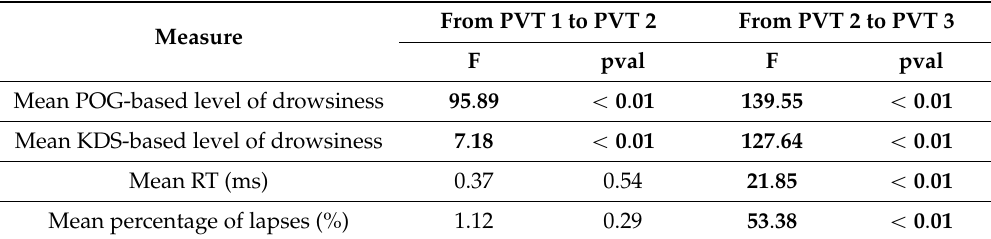
Table 2. Results of the separate, repeated ANOVA measurements (one degree of freedom) to distinguish differences in the levels of drowsiness (POG and KDS) and the (levels of) performance (RT and percentage of lapses) of all participants from PVT 1 to PVT 2 and from PVT 2 to PVT 3. Significant effects are shown in boldface.